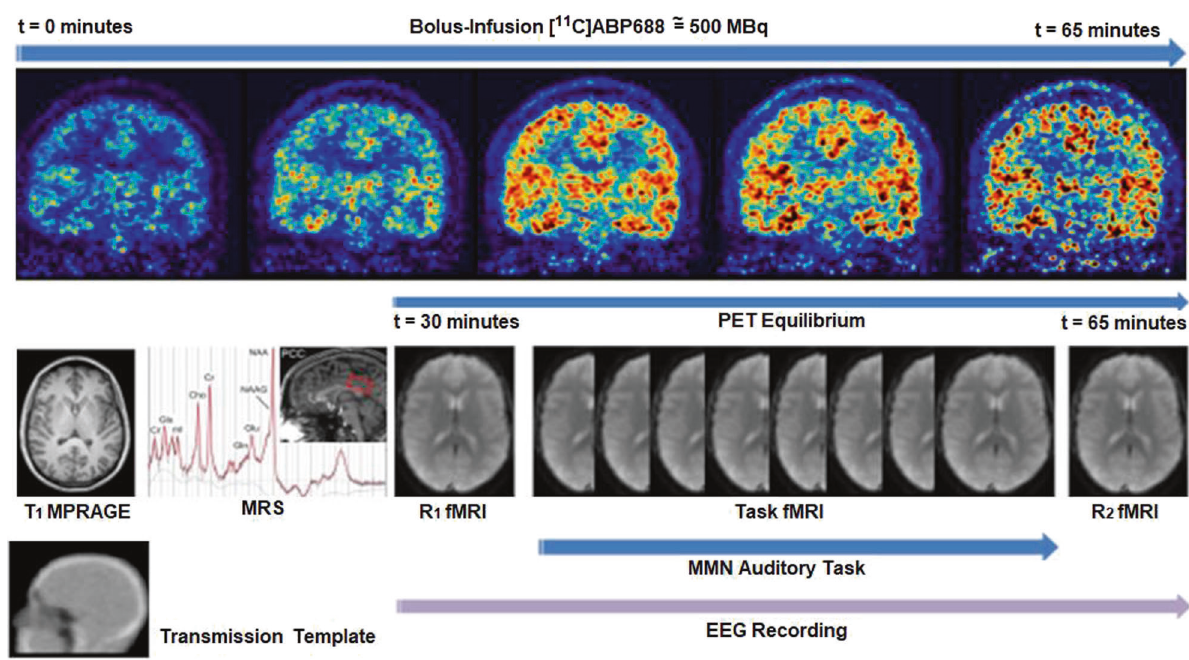
Fig. 1 Design of a measurement session. Schematic representation of the multimodal imaging